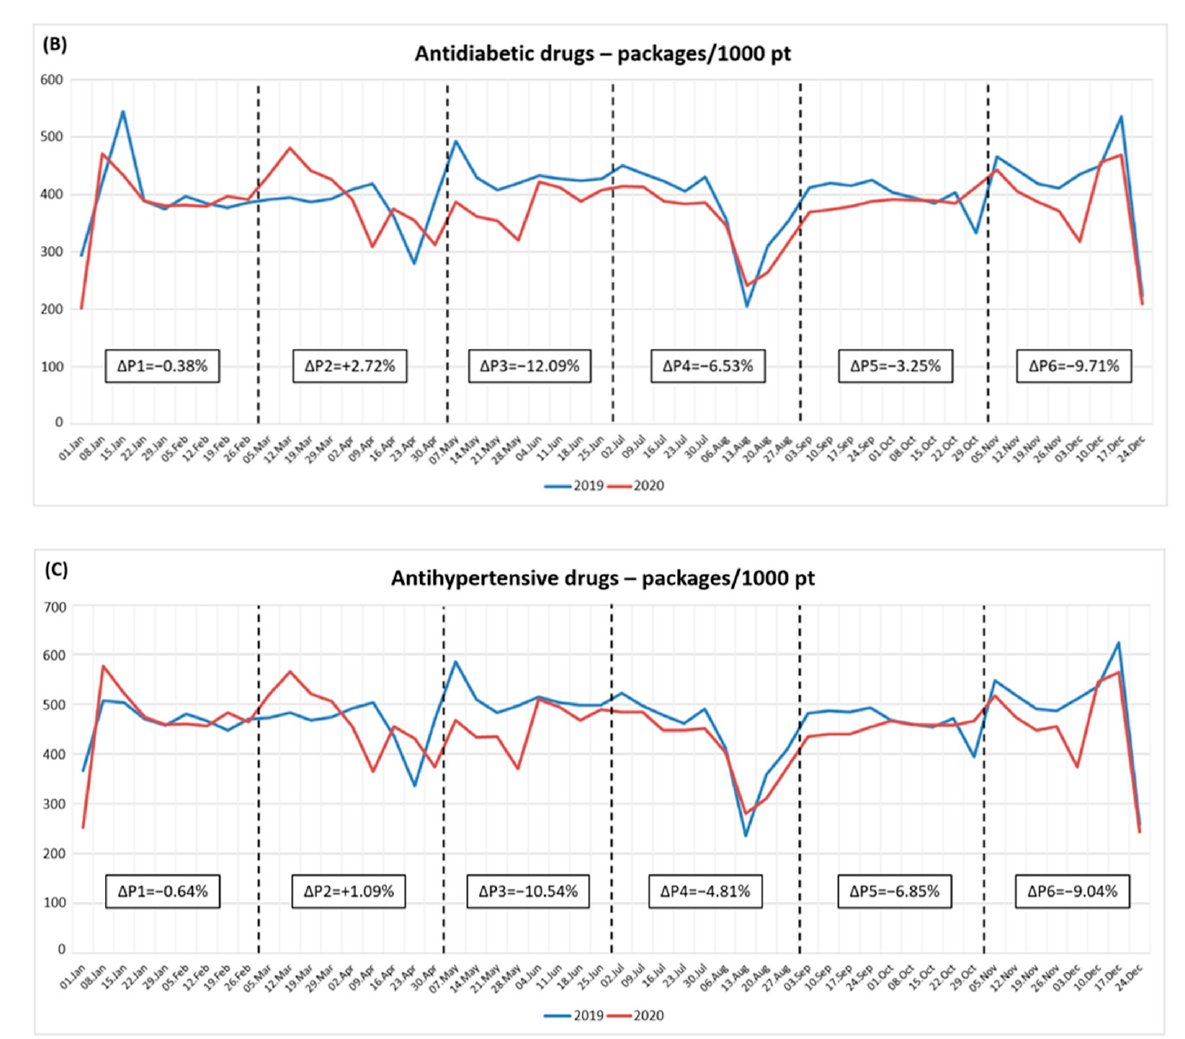
Figure 1. Fifty-two-week trends in chronic therapies dispensing in the population expressed as the number of dispensed packages per 1000 patients. ( A ) Lipid-lowering drugs. ( B ) Antidiabetic drugs. ( C ) Antihypertensive drugs.